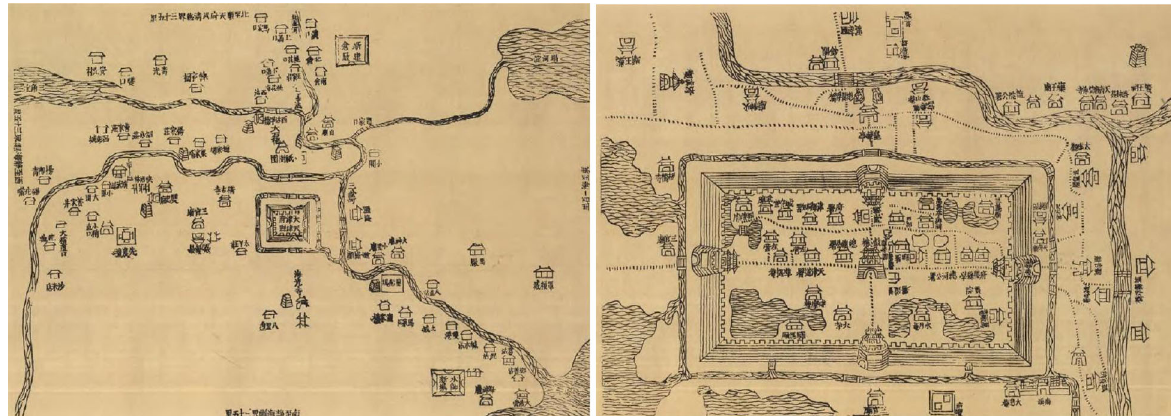
Fig. 3 Map of Tianjin with the city walls (Source: Annals of Tianjin District,